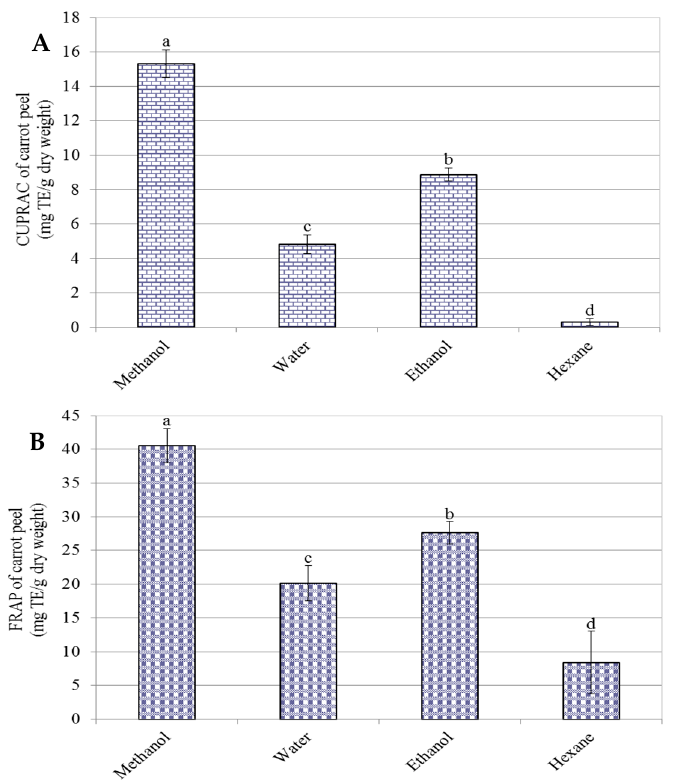
Figure 4. Antioxidant capacity of carrot peel extracted by four various solvents: ( A ) cupric ion reducing antioxidant capacity and ( B ) ferric reducing antioxidant power. Means and standard deviations were of triplicate. Different letters (a,b,c,d) within the columns denotes a significant difference between treatments ( p < 0.05).